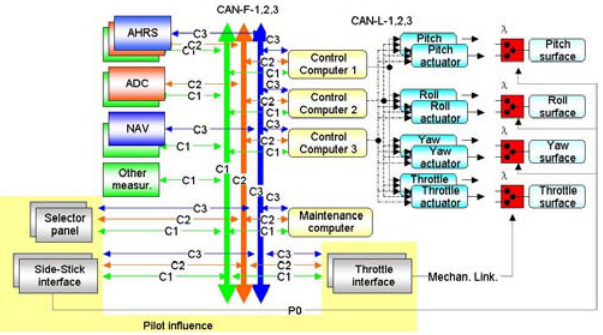
Fig 1. General architecture of the indirect control system of